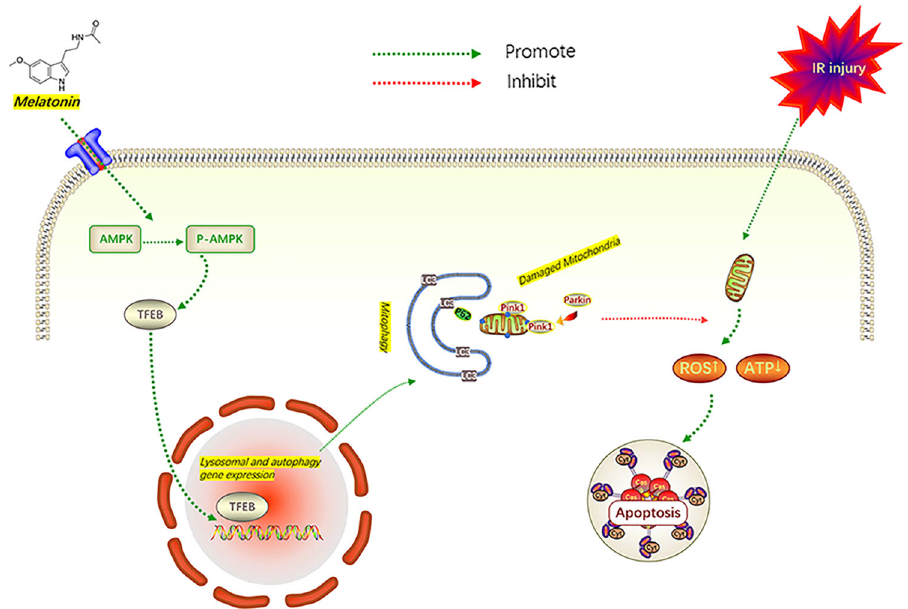
Fig. 9 Potential mechanisms of ML on HUVECs and fl ap survival. Schematic illustration showing ML alleviates apoptosis and oxidative stress injury via promoting Parkin-dependent mitophagy through the AMPK-TFEB signal